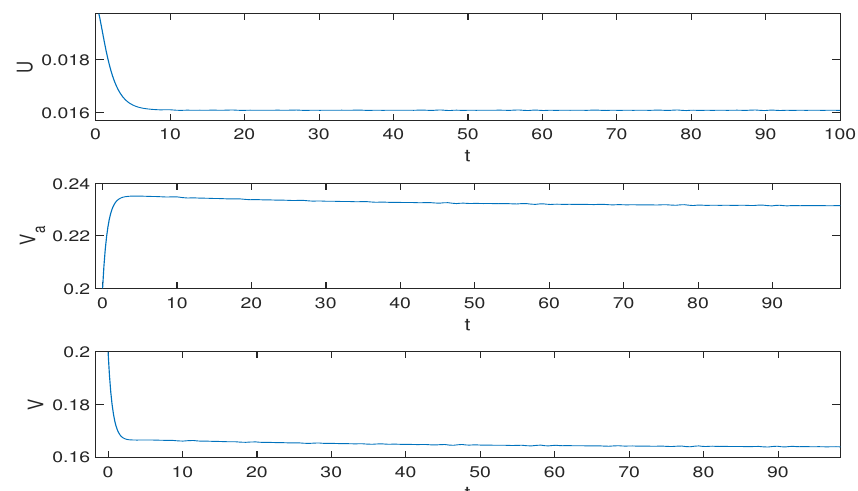
Figure 3. When τ = 0, the equilibrium P of system (1) is locally asymptotically